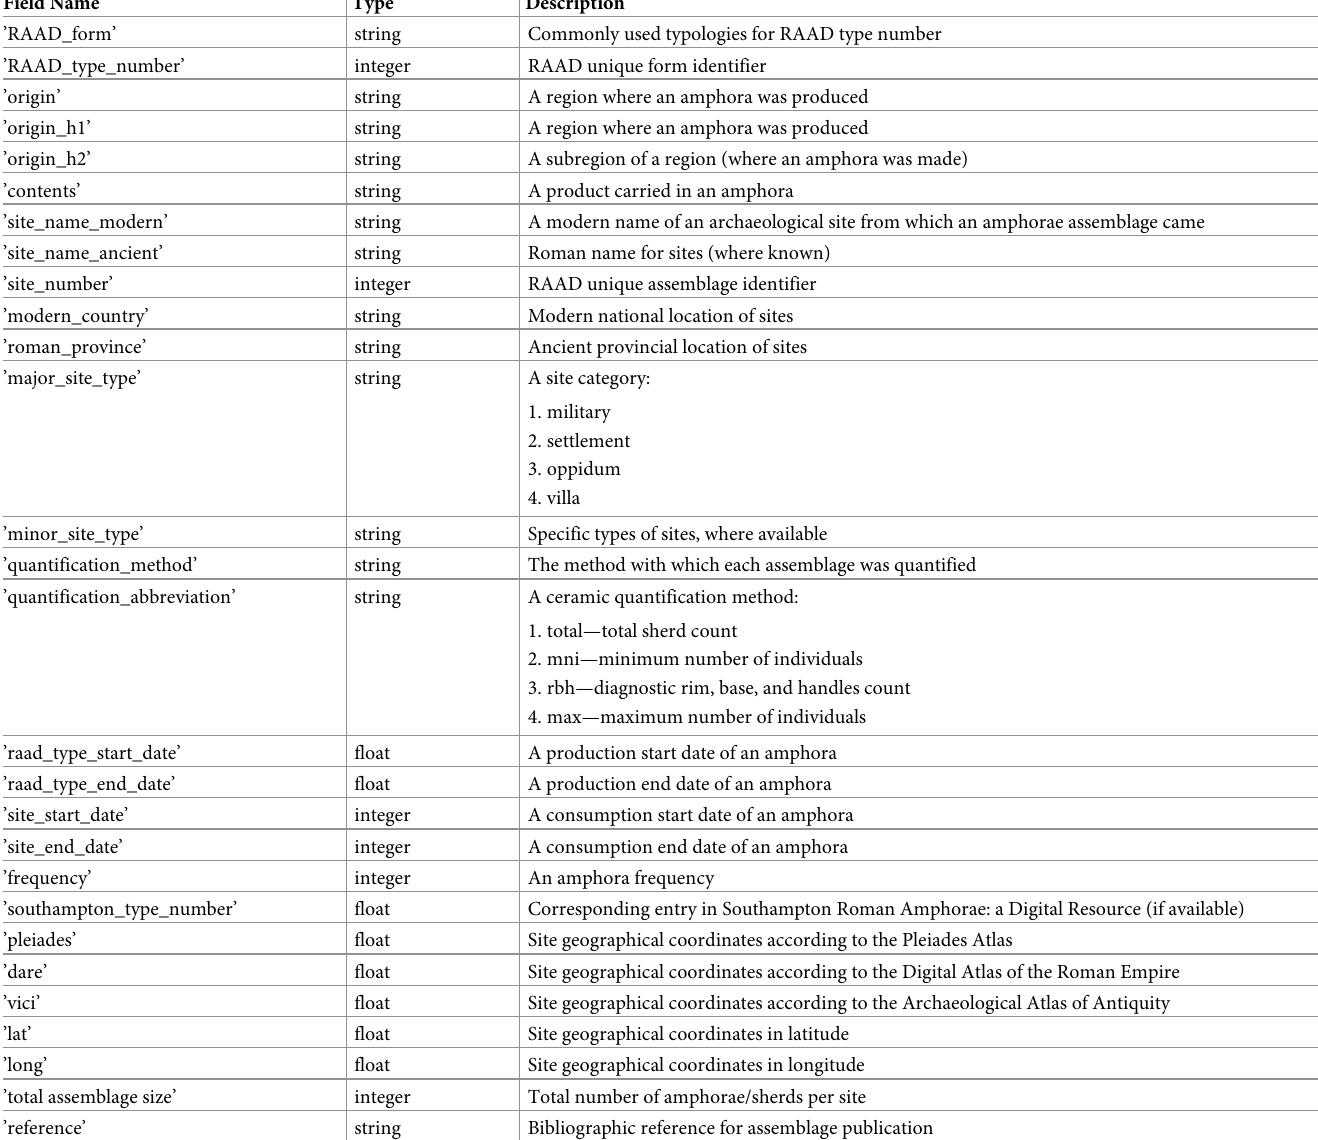
Table 1. Attributes of restructured RAAD.CSV file used for this